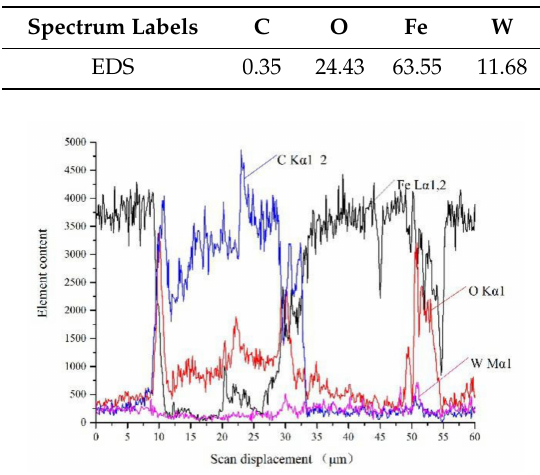
Figure 22. SEM image of the 80 W power group 1.6 mm / s at the load of 2000 g: ( a ) wear scar morphology; ( b ) enlarged view of localized wear; ( c – e ) enlarged view of textured wear; ( f ) enlarged view of ( e ) abrasive particles. Table 10. EDS data of Figure 22e.